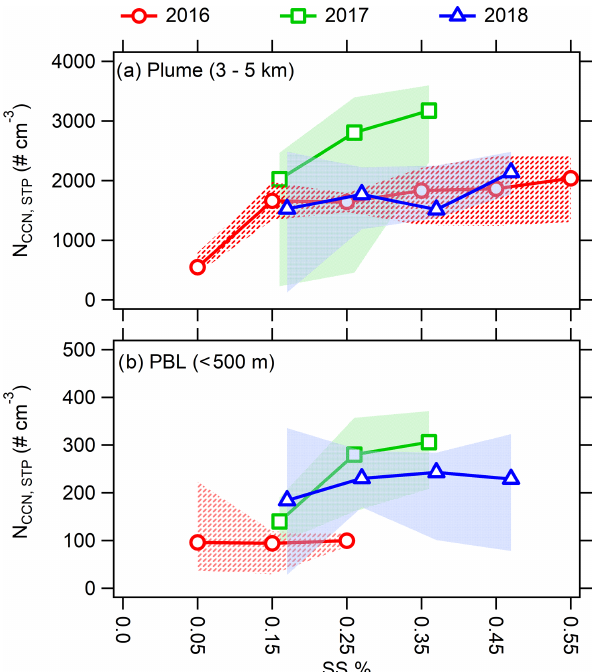
Figure 16. Composite CCN supersaturation spectra (concentration of CCN as a function of the applied supersaturation, SS) for (a) the free-tropospheric BB plume and (b) the MBL within a region (5– 15 ◦ S and 2.5–7.5 ◦ E) sampled during all three